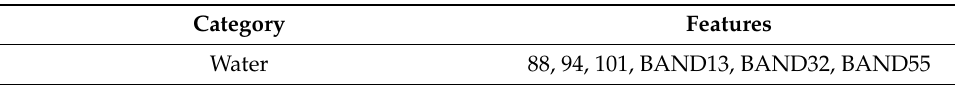
Table 4. Feature selection of water body.